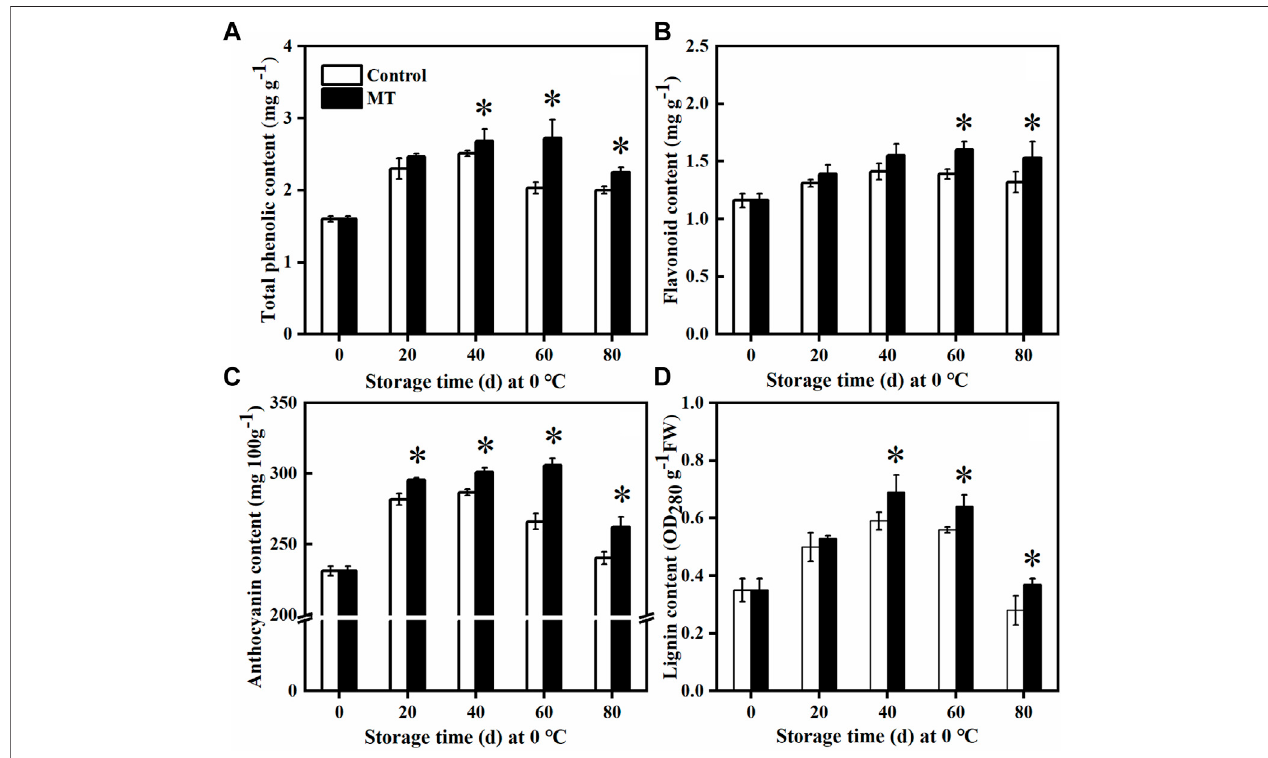
FIGURE 5 | Effects of MT treatment on the total phenol (A) , fl avonoid (B) , anthocyanin (C) , and lignin (D) contents of blueberry fruits during postharvest storage at 0 ° C. Here, symbol * indicates signi fi cant differences ( p < 0.05). Data are presented as the mean ± SD.